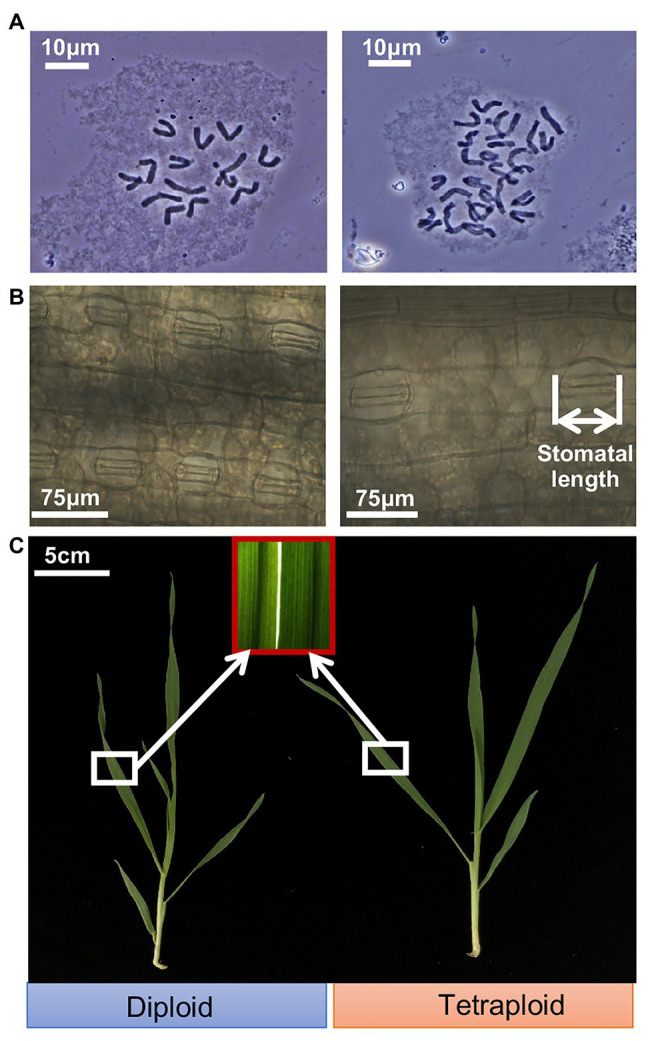
Ploidy analysis and appearance of shoots of the diploid and tetraploid barley seedlings. (A) Chromosomes of the diploid (2n = 14) and tetraploid (2n = 28) barley at mitotic metaphase. (B) Closed stomas and straightened stomatal guard cells. (C) Shoots of the diploid and tetraploid barley seedlings.